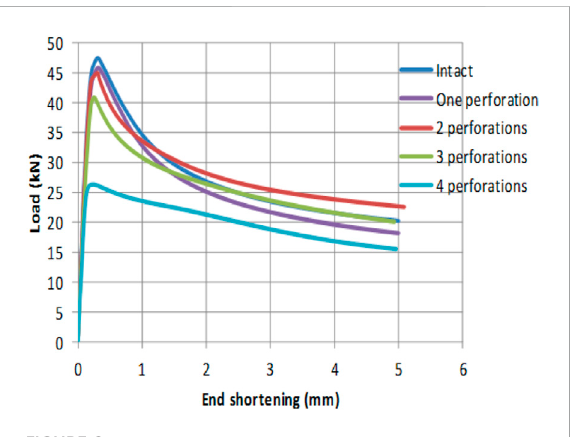
FIGURE 8 Load end shortening relationship of perforated plates compared with the intact plate.